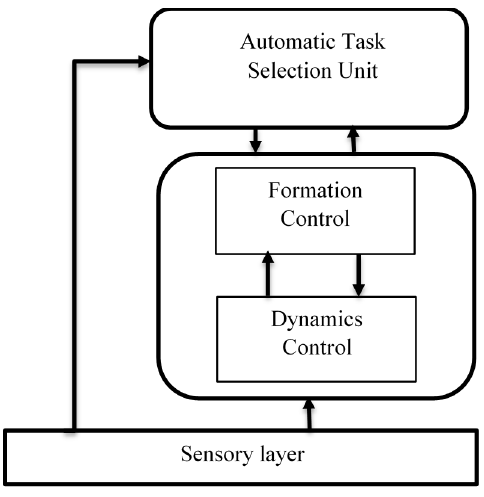
Figure 1. The proposed